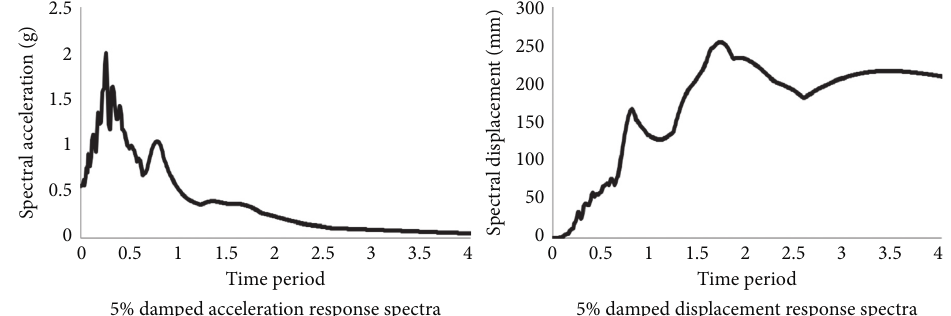
Figure 3: Input excitation and response spectra (figure is reproduced from Ahmad et al.